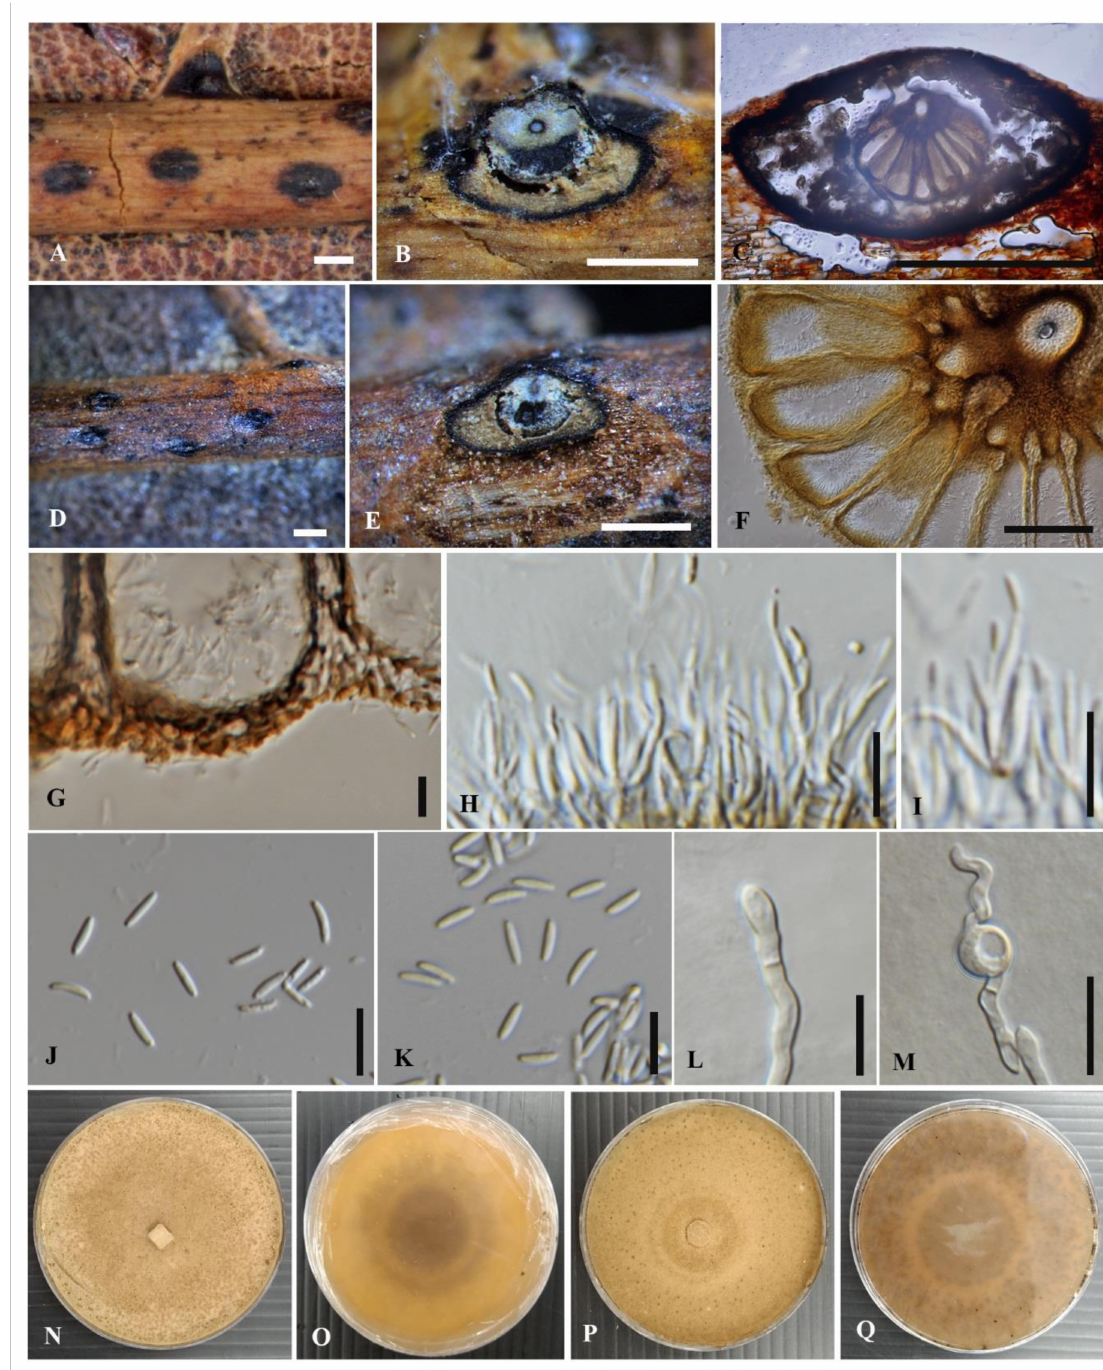
Figure 5. Cytospora shoreae (MFLU 21-0049, holotype (C–E,G,H,J,L,N,O) and MFLU 21-0050, paratype (A,B,F,I,K,M,P,G)). ( A , D ) Conidiomata on host substrate. ( B , C , E , F ) Longitudinal sections through conidioma. ( G ) Peridium. ( H,I ) Conidio- phores and conidiogenous cells with attached conidia. ( J , K ) Conidia. ( L , M ) Germinating conidia. ( N – Q ) Colonies on PDA plate (9 cm diam.) (( N , P ) from above, ( O , Q ) from reverse). Scale bars: ( A – E ) = 500 µ m, ( F ) = 50 µ m, ( G – M ) = 10 µ